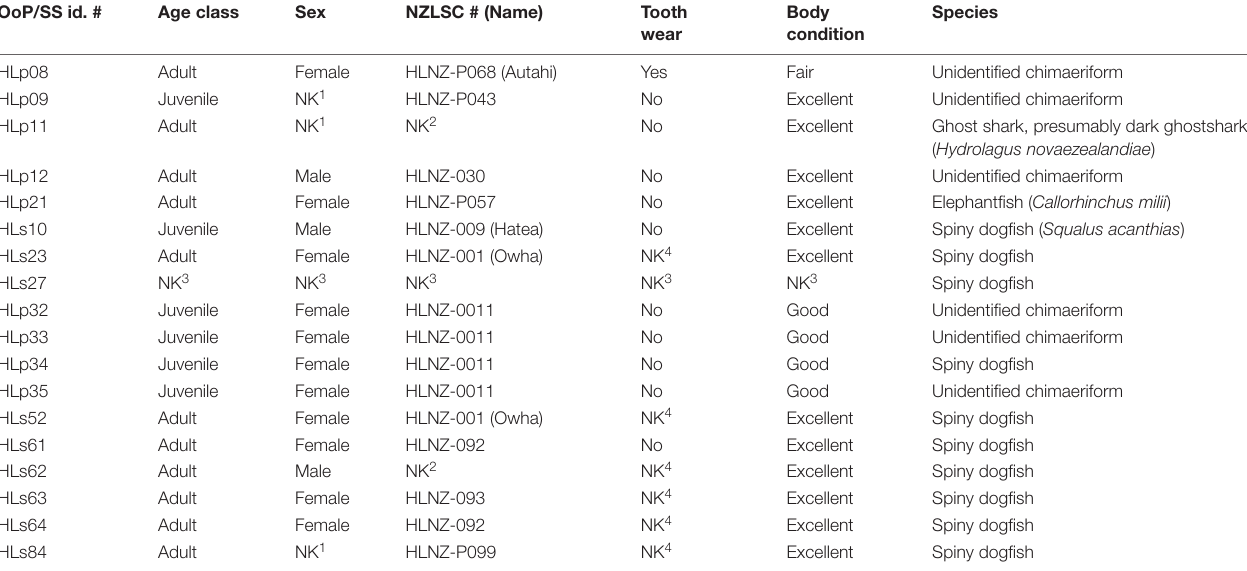
TABLE 3 | Individual assessment of leopard seals ( Hydrurga leptonyx ) who have been documented predating on chondrichthyans in New Zealand. OoP/SS id.